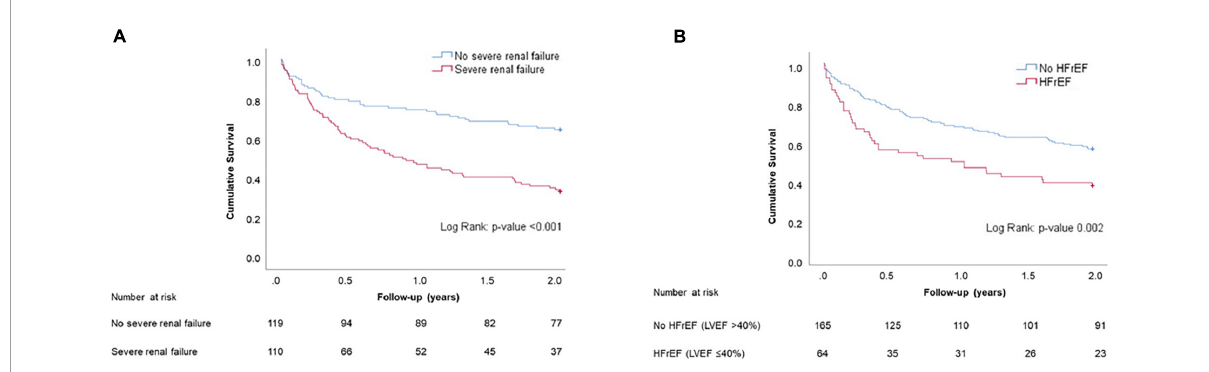
FIGURE4 Panel (A) : Estimated cumulative survival (Kaplan–Meier curves) of patients with and without severe renal failure up to 2-year follow-up. Panel (B) : Estimated cumulative survival (Kaplan–Meier curves) of patients with and without HFrEF up to 2-year